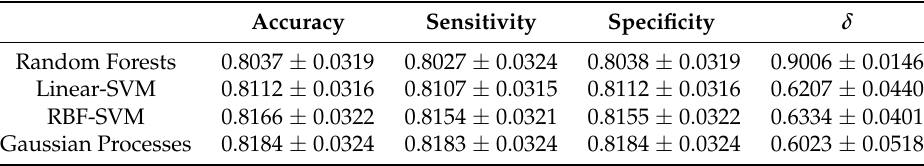
Table 6. AUC, accuracy, sensitivity and specificity related to the bright-lesion detection on DIARETDB1 database. Results were optimized to the best sensitivity-specificity